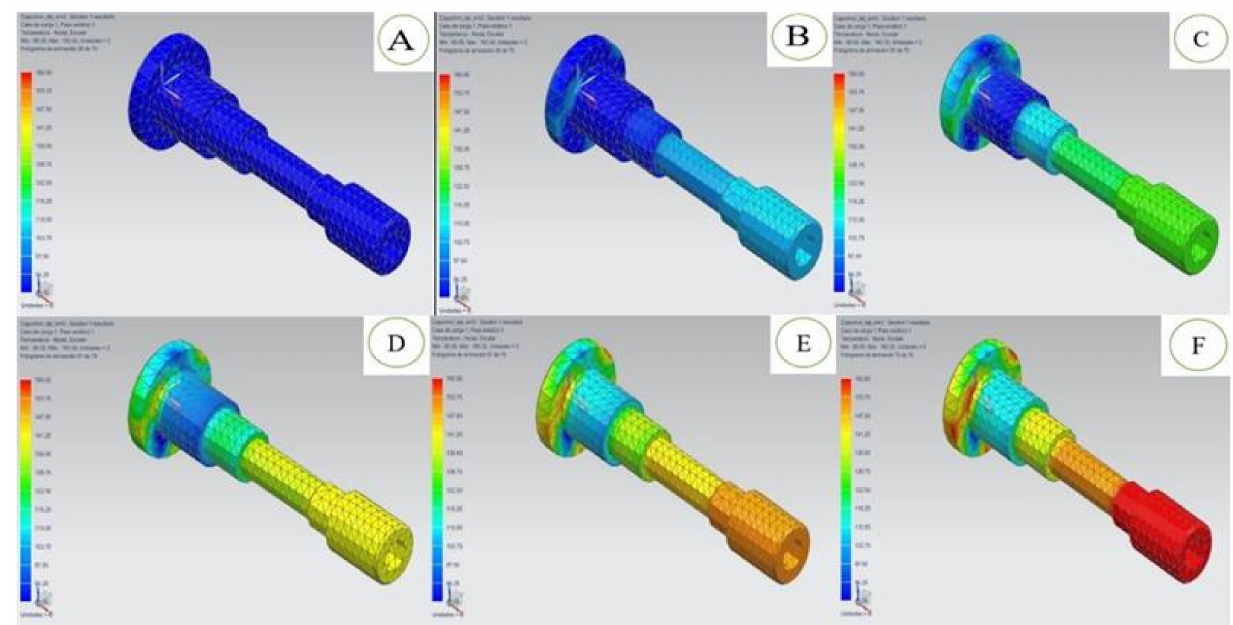
Figure 11. Thermal sequence of polypropylene from ( A – F ) related to the time of simulation.